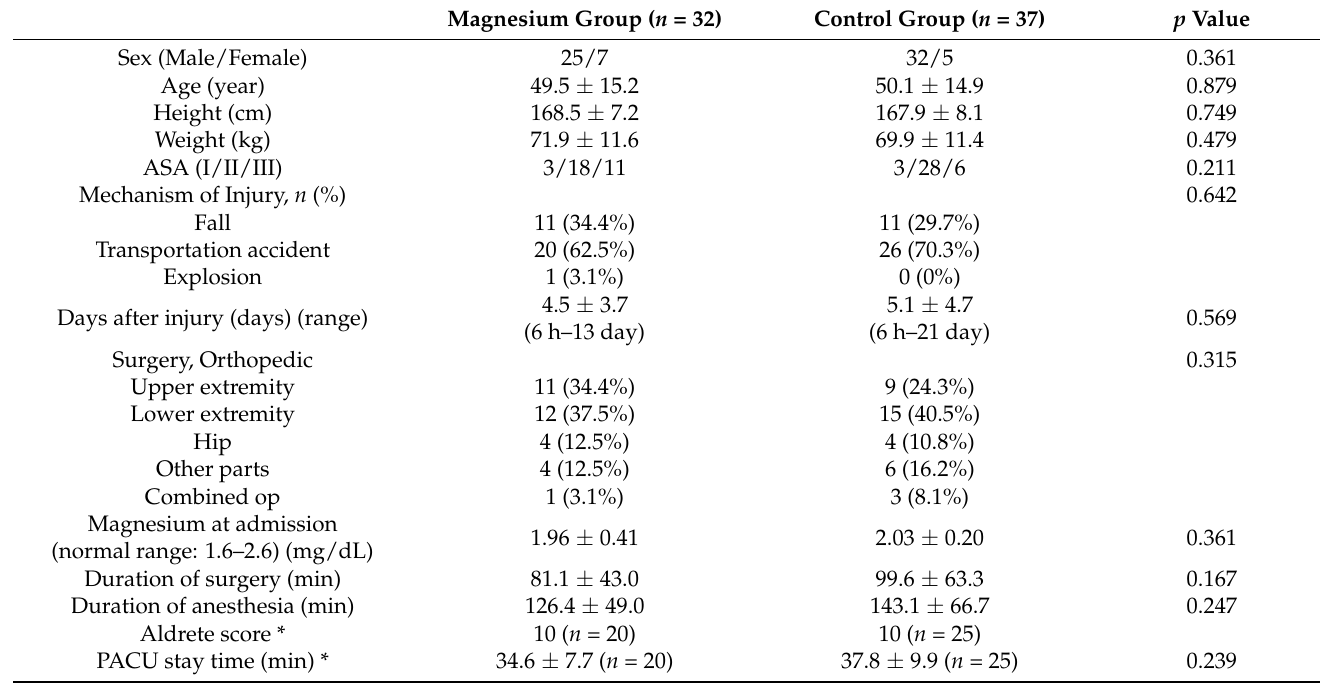
Table 1. Baseline characteristics of patients and perioperative data assigned to magnesium or the control